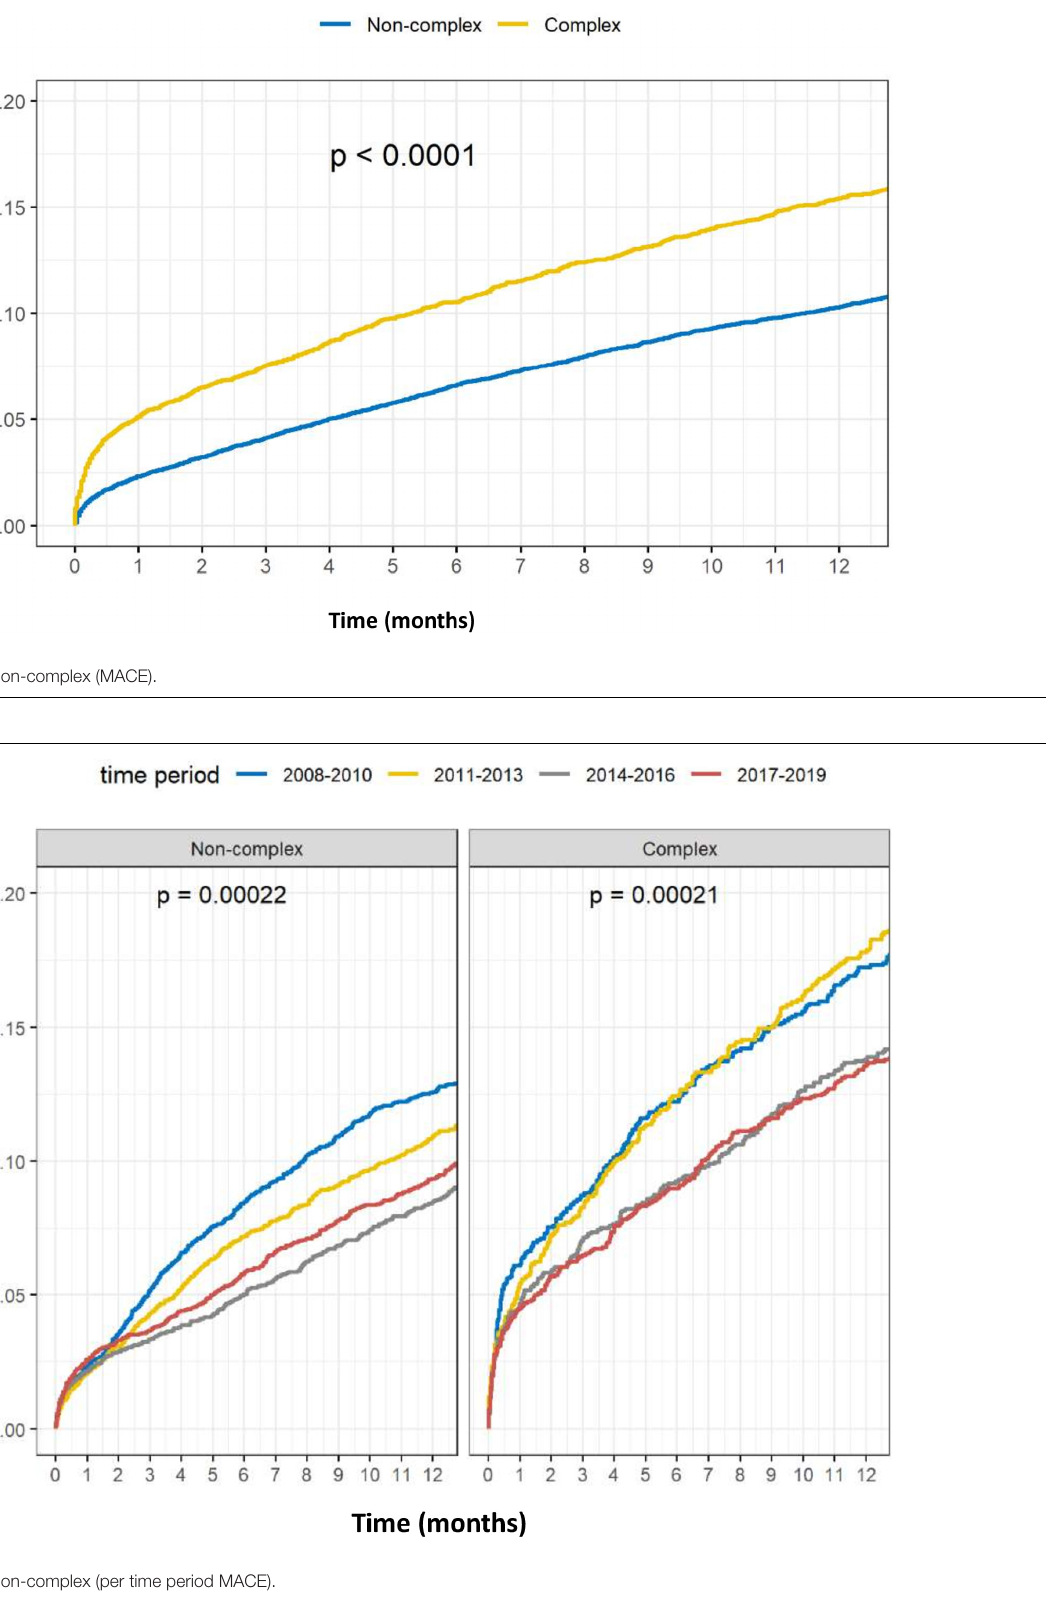
FIGURE 5 | Complex vs. non-complex (per time period